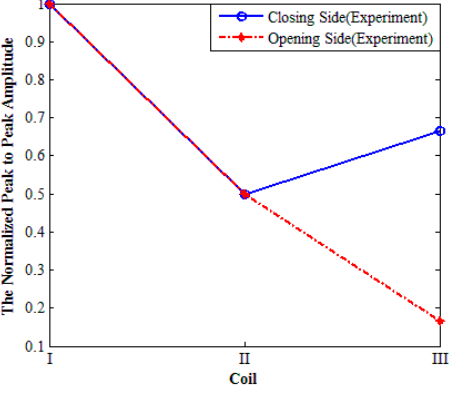
Figure 9. The normalized peak-to-peak amplitude of echo on the right end of aluminum plate.